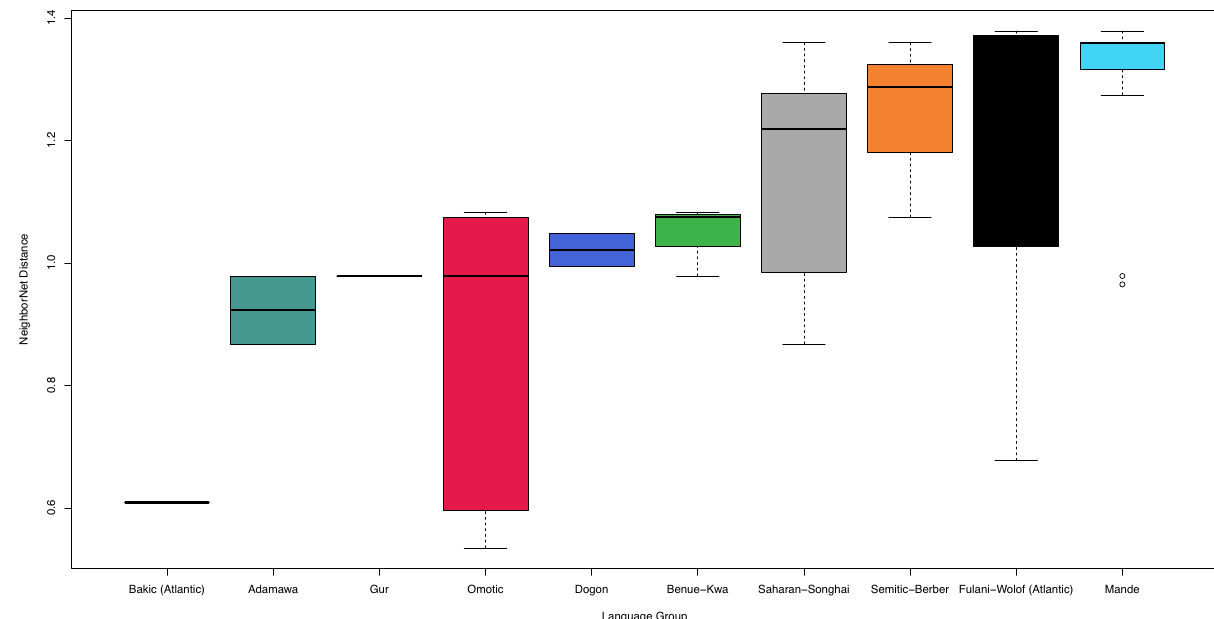
Fig. 6 Boxbplot of NeighborNet phenetic distances by language group. Boxplots of language NeighborNet phenetic distances, labeled by language group (Saharan-Songhai language groups and Berber-Semitic language groups each combined for plotting clarity). Boxes represent the interquartile range and whiskers extend to 1.5 times the interquartile